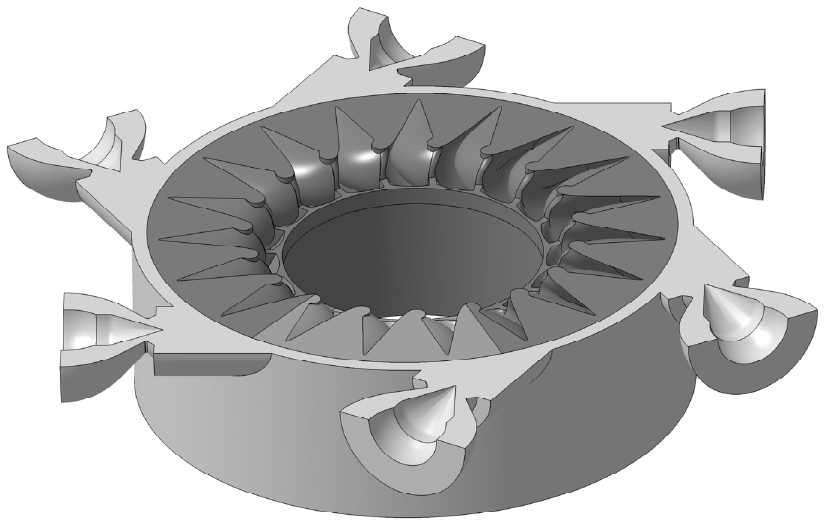
Figure 5. Geometric model of the runner simulation domains.